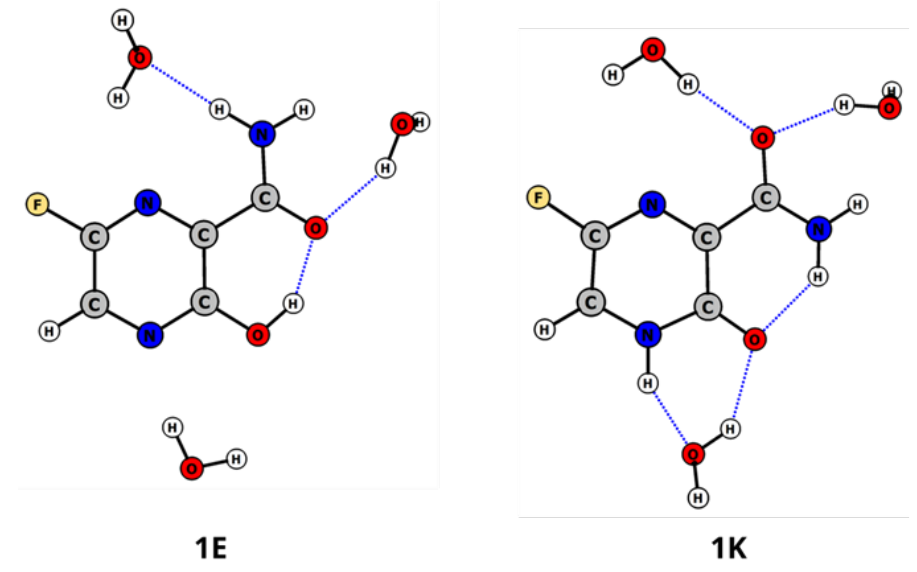
Figure 4. The optimized geometry (M06-2X/def2-TZVPPD) of water–favipiravir clusters with three water molecules (in acetonitrile as implicit solvent) in the ground state (S 0 ) for the most stable enol 1E and keto 1K tautomers.